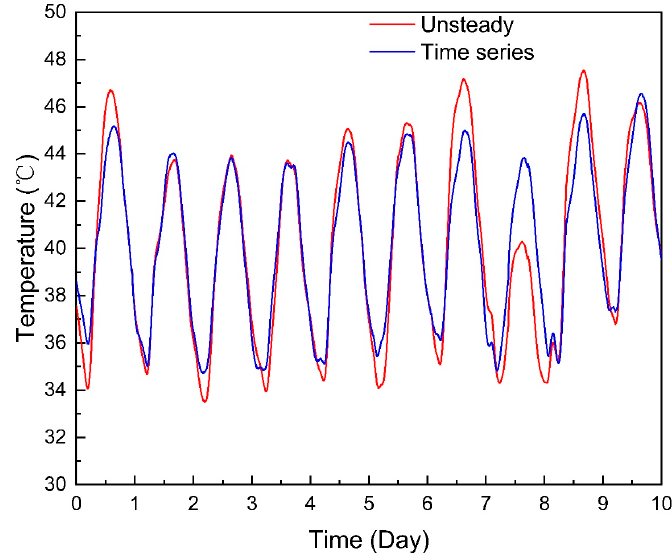
Figure 12. Total fitting.